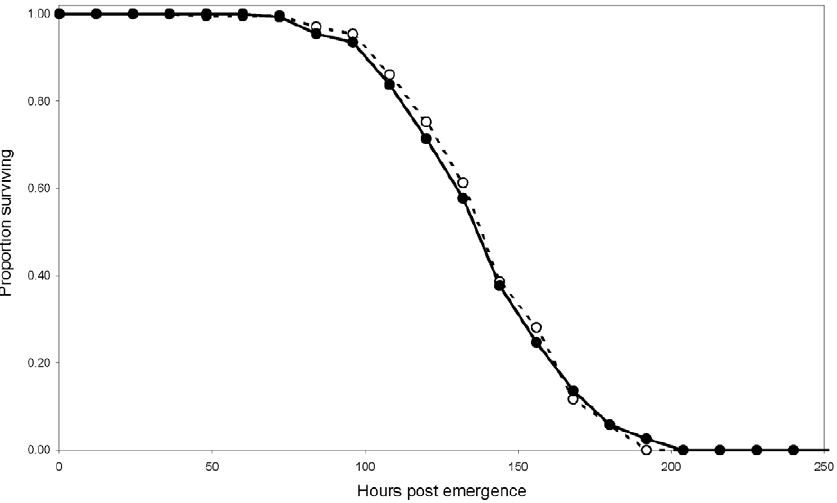
Figure 2. Survival curves for LR (n=238; dotted line) and LR[ w Pip(Is)] males (n=154; solid line).